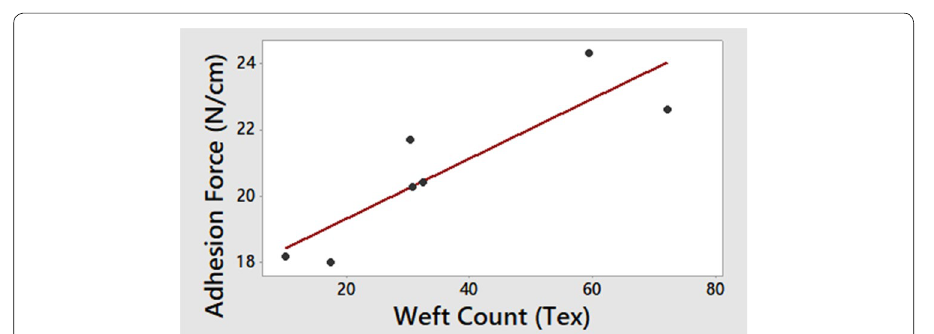
Fig. 8 Effect of weft count on adhesion force